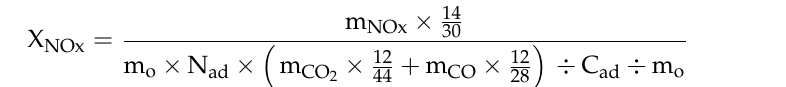
Figure 6. NOx emission curves at different temperatures.